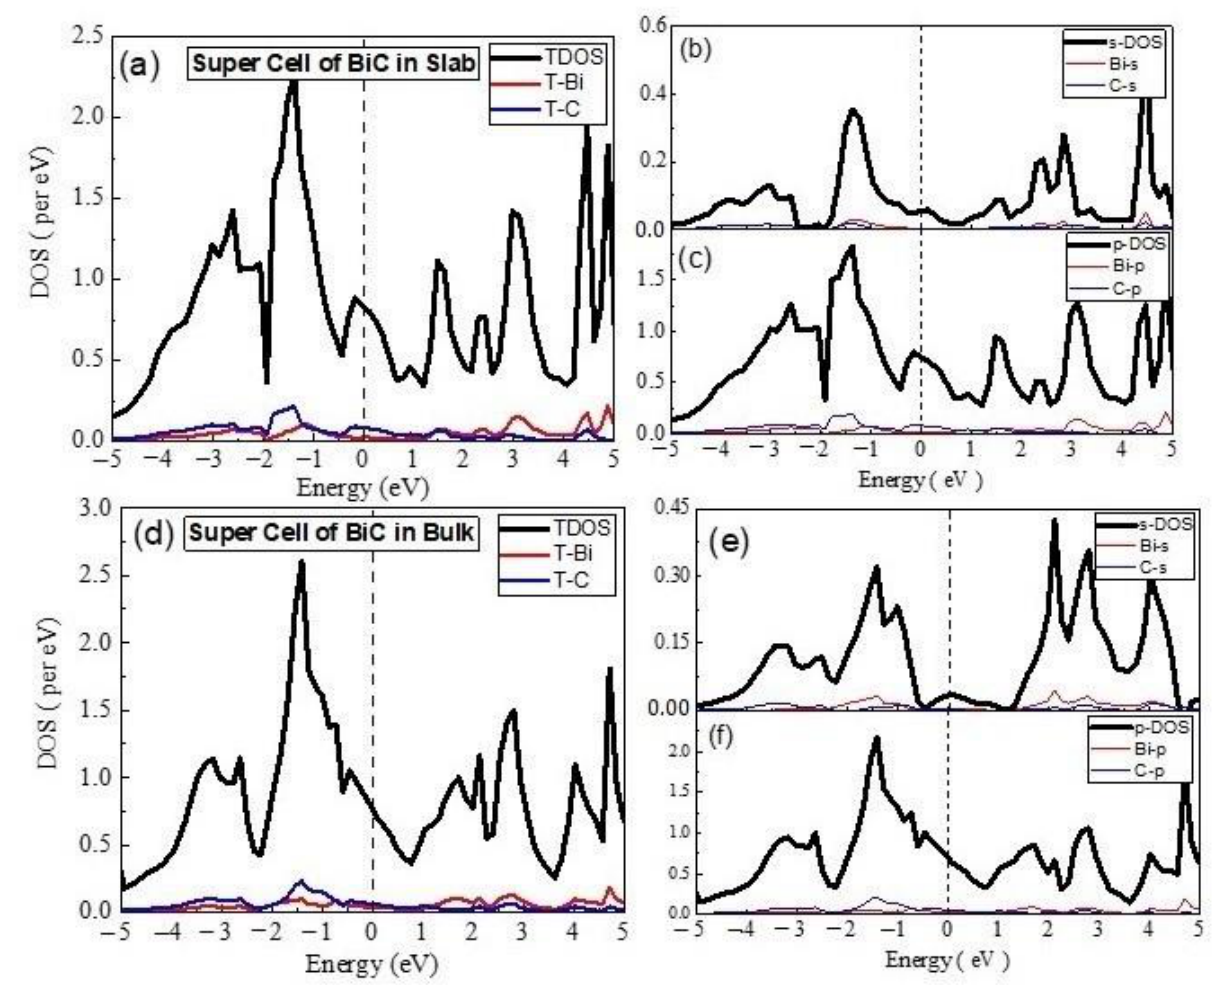
Figure 3. The calculated total density of states (TDOS) and partial density of states for BiC Super cell ( a ) TDOS of slab ( b ) s-DOS of slab ( c ) p-DOS of slab ( d ) TDOS of bulk ( e ) s-DOS of bulk ( f ) p-DOS of bulk. The Fermi level was adjusted at 0 eV.